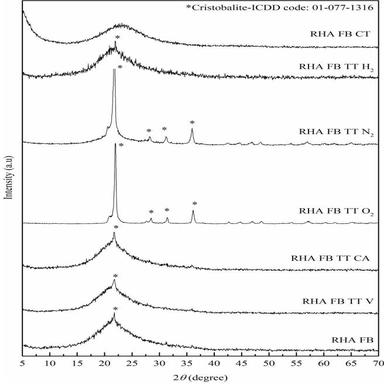
Diffractograms of raw RHA FB and the different treatments performed.